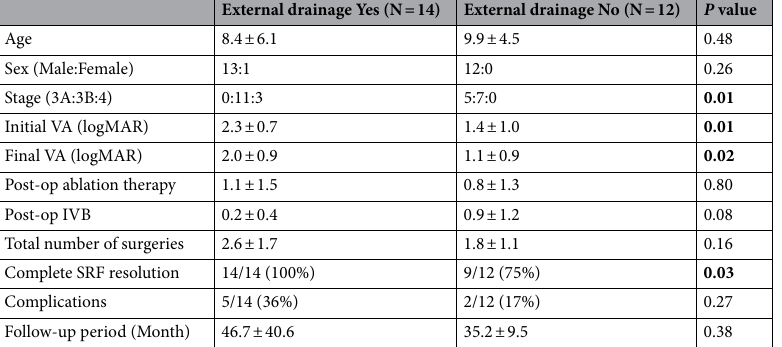
Table 2. Comparison of surgical outcomes for vitrectomy with or without external subretinal fluid drainage. IVB, intravitreal injection of bevacizumab; SRF, subretinal fluid. Significant P values in